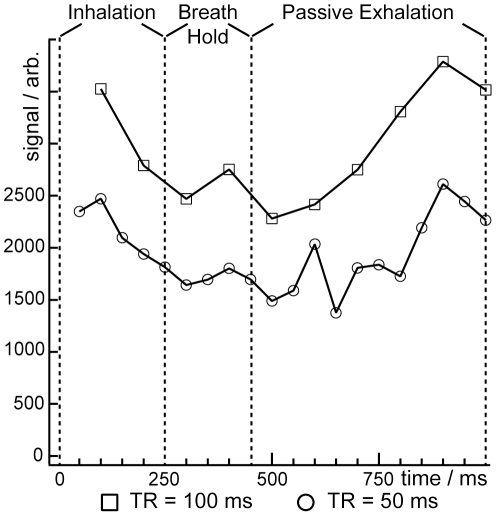
Signal dynamics during the breath cycle.Data are the gaseous HP 129Xe signal intensity observed from two different animals using 50-ms (circles) and 100-ms (squares) repetition times between 90° RF pulses. Lines are intended only as guides.